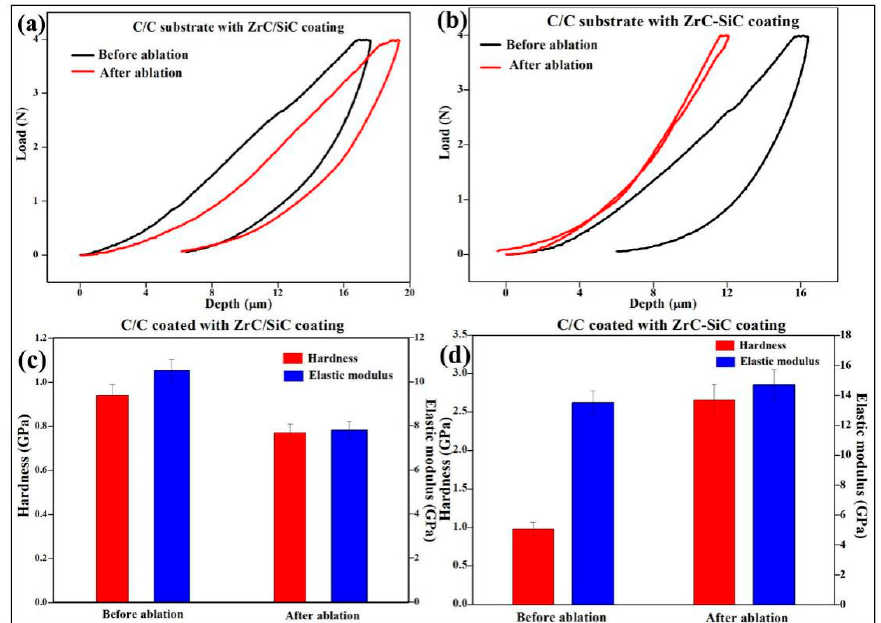
Figure 10. The micro-indentation test results of C/C substrates covered by ZrC/SiC and ZrC-SiC coatings before and after ablation for 60 s. The load-depth curves ( a ) and mechanical properties ( c ) of C/C substrate coated with ZrC/SiC double-layer coating before and after ablation; ( b ) and mechanical properties ( d ) of C/C substrate coated with ZrC-SiC coating before and after ablation.